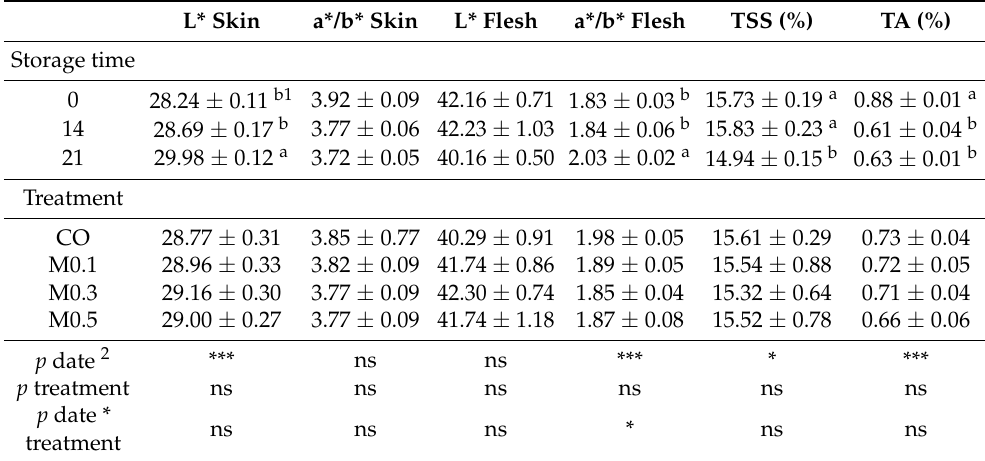
Table 1. Mean values ± SE of skin and flesh colour, total soluble solids (TSS), and titratable acidity (TA) of ‘Samba’ cherries in relation to storage time and